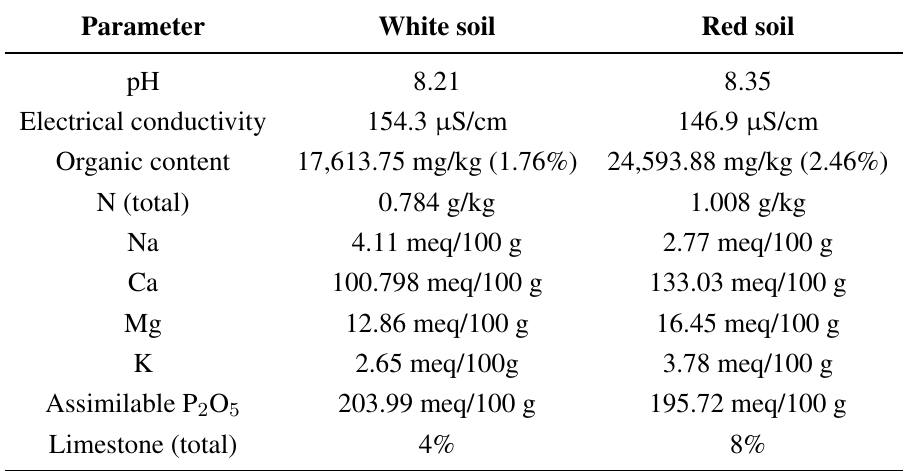
Table 1. Characteristics of the two types of soil employed in the